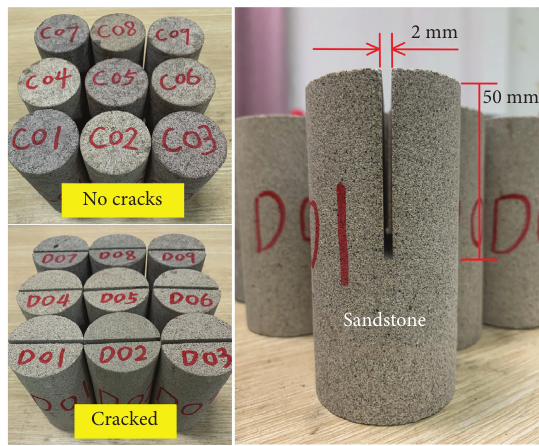
Figure 3: Triaxial circulation sandstone samples.